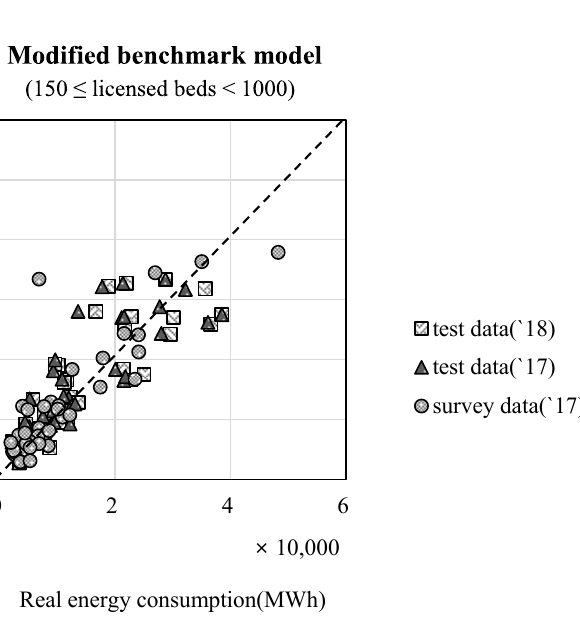
Figure 6. Real and predicted energy consumption relationship according to the benchmark model.